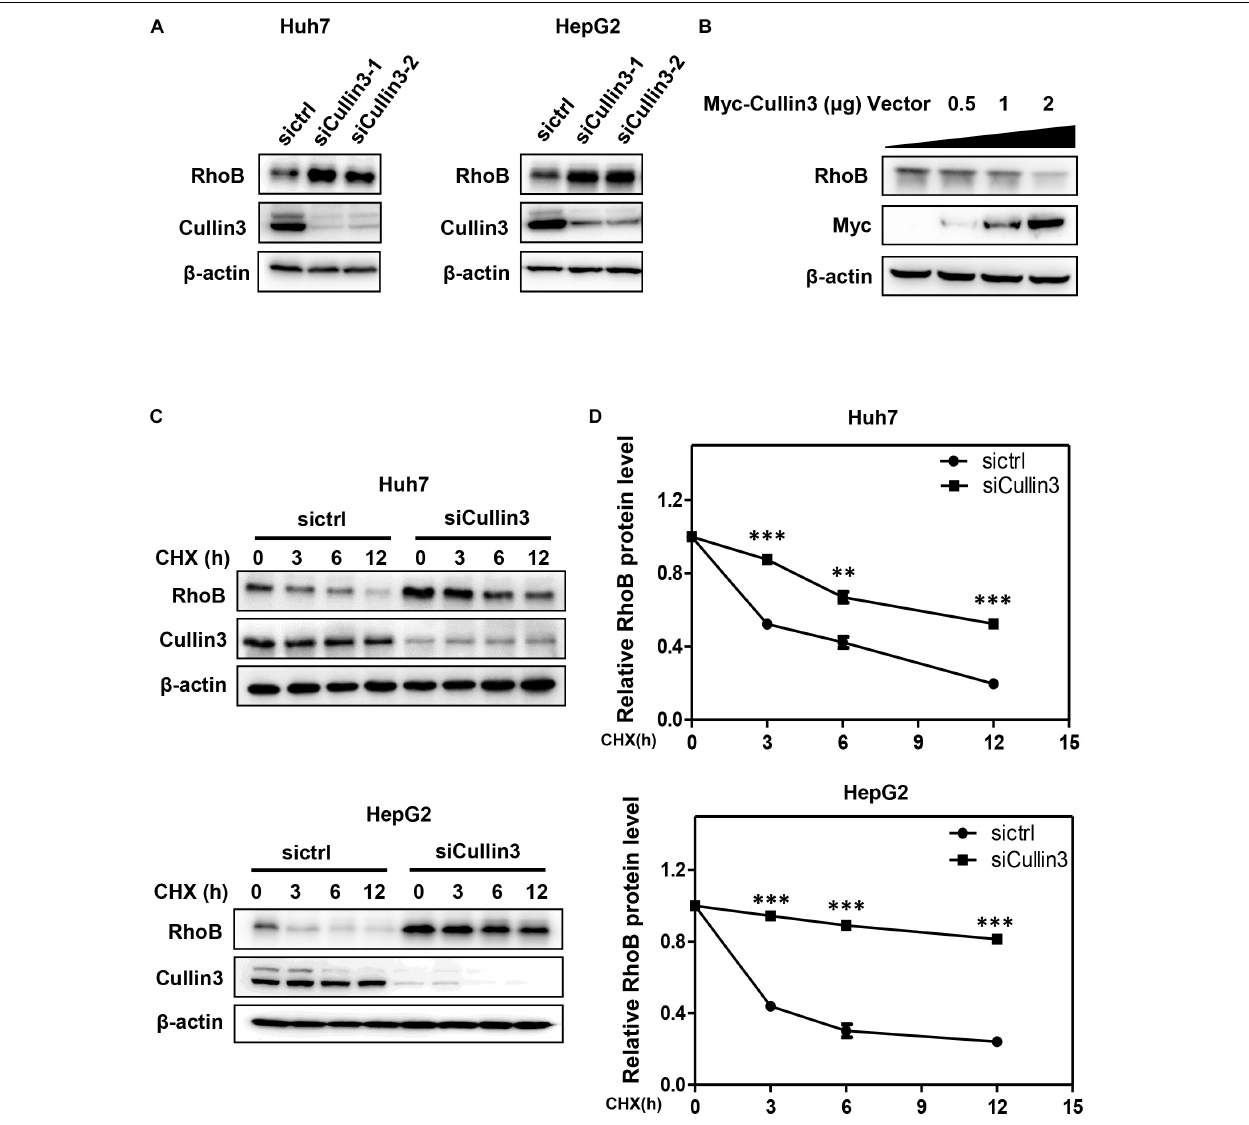
FIGURE 1 | Cullin3 regulated protein degradation of RhoB. (A) Downregulation of Cullin3 induced remarkable RhoB accumulation in both Huh7 and HepG2 cells. Cells were transfected with ctrl (control), Cullin3-1 or Cullin3-2 siRNA for 96 h, and cell lysates were harvested for western blot analysis. (B) Cullin3 overexpression decreased the protein levels of endogenous RhoB. HEK293T cells were transfected with indicated concentration of Myc-Cullin3 plasmid or empty vector, and cell lysates were harvested for western blot analysis. (C) Knockdown of Cullin3 extended the half-life of RhoB. Cells were transfected with indicated siRNAs then treated with 50 µ g/mL cycloheximide (CHX) for the indicated time and harvested for western blot analysis. (D) The protein levels were quantified by densitometric analysis and statistical analysis was performed. ∗∗ P < 0.01 and ∗∗∗ P < 0.001 vs. control group.